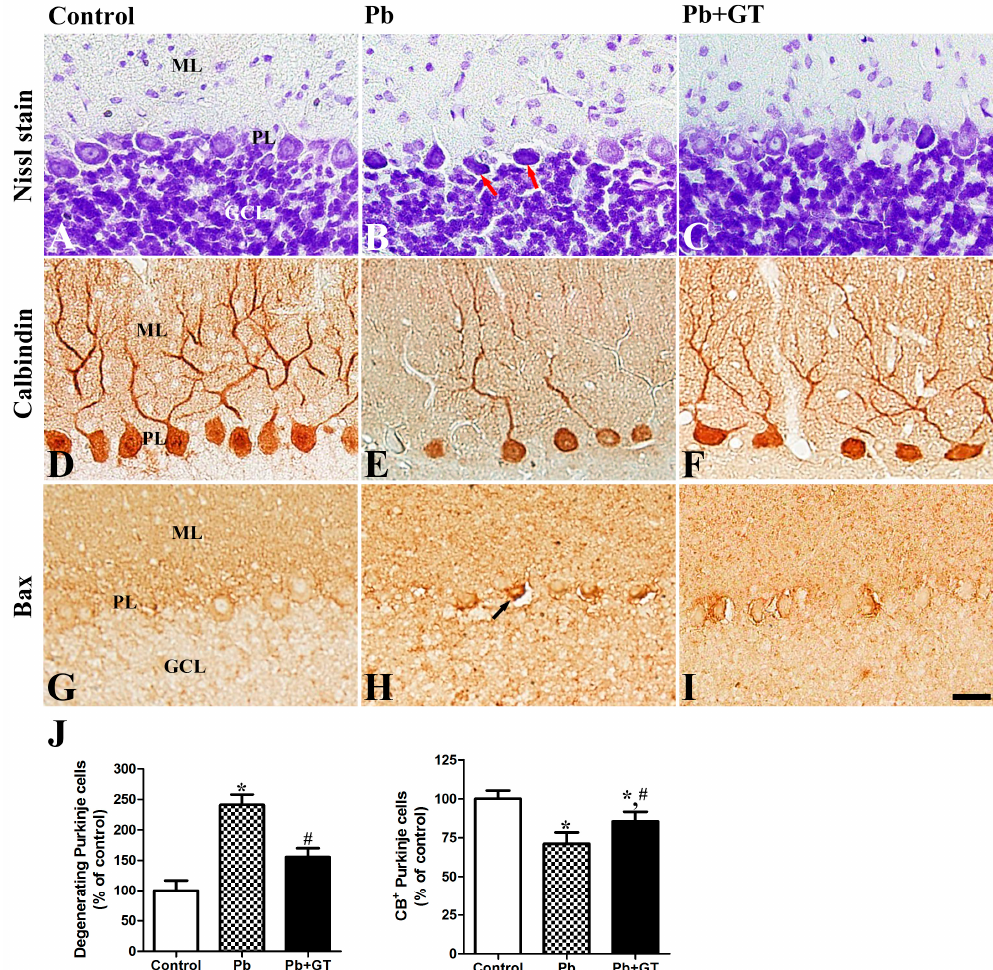
Figure 2. Effects of gintonin on Pb-induced cerebellar Purkinje cell impairments. Nissl staining ( A–C ), immunohistochemistry for calbindin (CB) ( D–F ), and immunohistochemistry for Bax ( G–I ) in the cerebellum of offspring from control, Pb, and Pb plus gintonin (Pb+GT) groups. GCL, granular cell layer; ML, molecular layer; PL, Purkinje cell layer. Bar = 25 μ m. Degenerating Purkinje cells (red arrow), CB-immunoreactive Purkinje cells, bax-immunoreactive cells (arrow) are detected in the Purkinje cell layer. ( J ) The numbers of degenerating Purkinje cells ( p < 0.0001, one-way analysis of variance) and CB-immunoreactive Purkinje cells ( p < 0.0001, one-way analysis of variance) in the cerebellum are expressed as percentages of the value in the control group (n = 12 per group). * p < 0.05, compared to control group; # p < 0.05, compared to Pb alone, Tukey’s post-hoc test. The bars indicate means ± standard error of the mean.